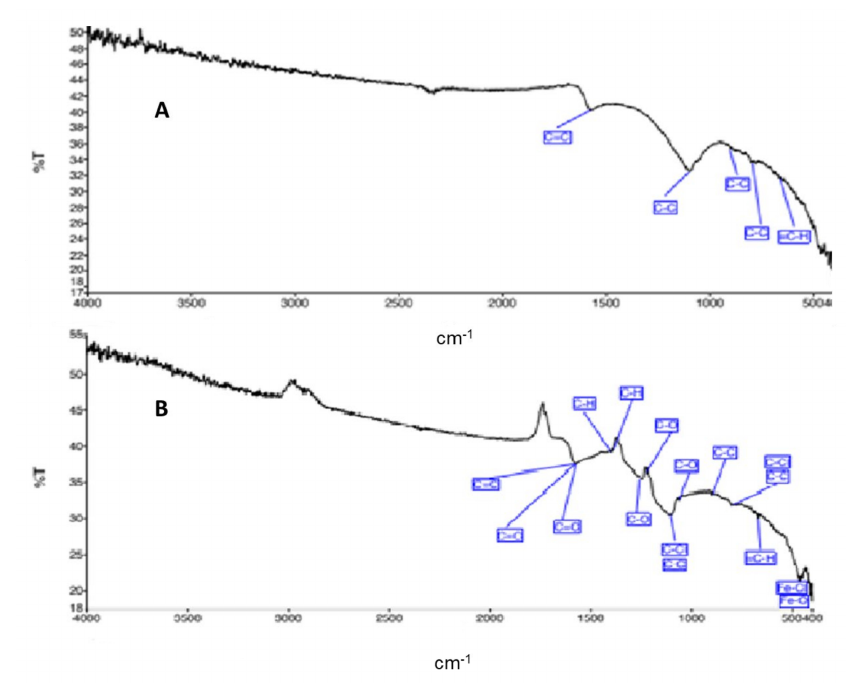
Figure 6. FTIR spectrum of activated carbons: ( A ) C -conv and ( B ) C - FeCl